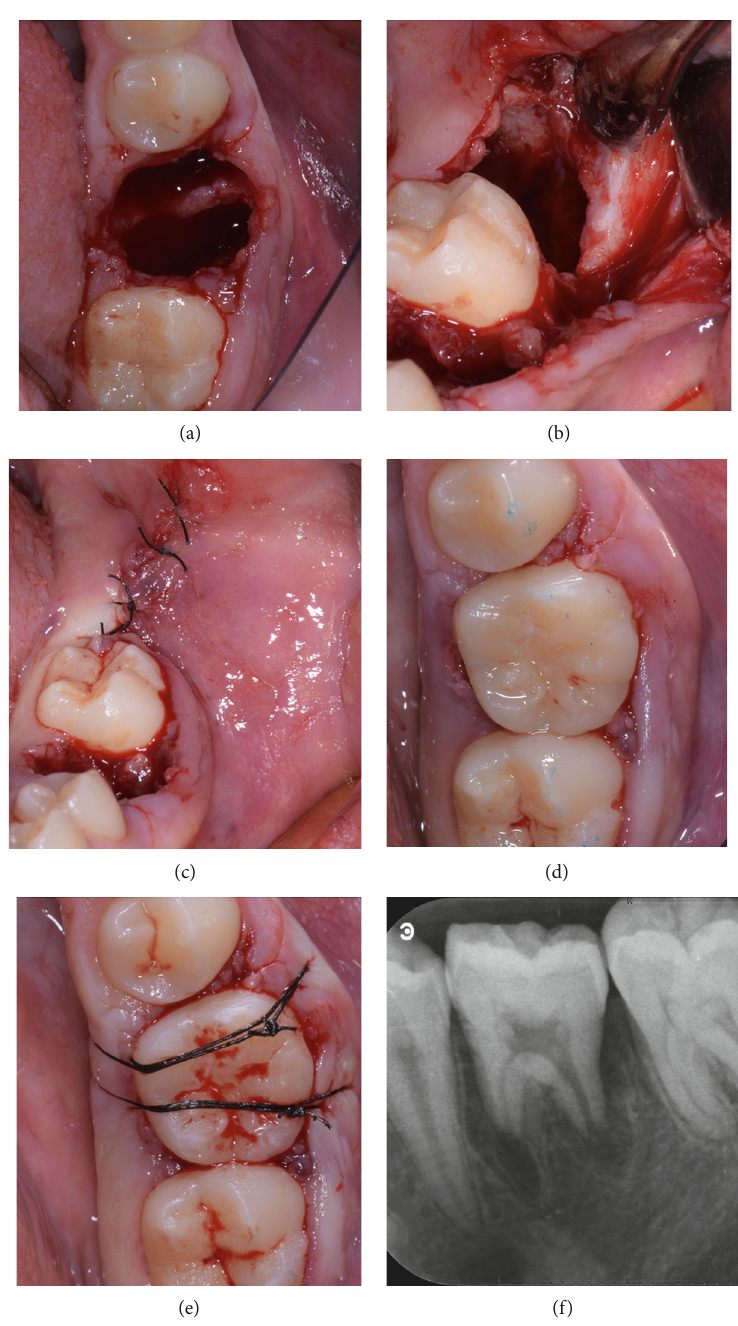
Figure 2: Tooth 36: (a) alveolar extraction socket; (b) alveolar extraction socket of left third molar; (c) sutures of third molar extraction site; (d) transplanted tooth in position 36; (e) cross-sutures for stabilization; (f) periapical radiograph immediately after